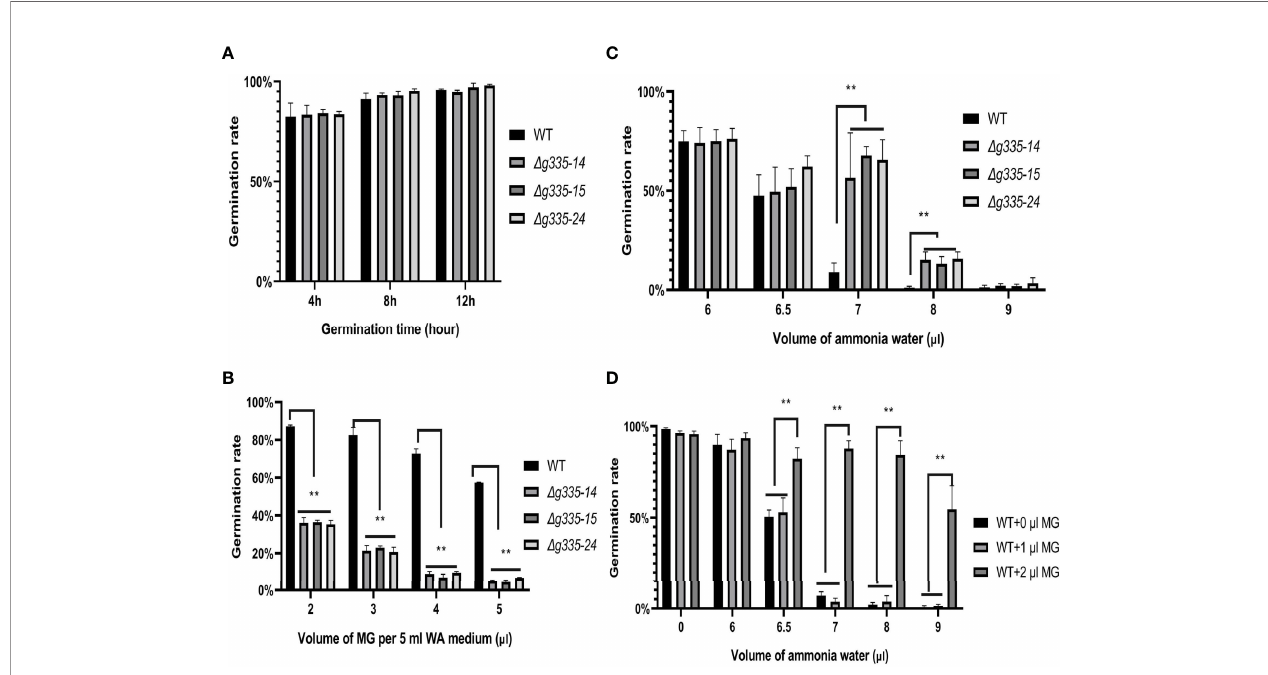
FIGURE 3 | Measurement of ammonia resistance of mutant strains on WA medium. (A) Determination of conidial germination rates of mutant and wild-type strains at 4, 8, and 12 hours. (B) Determination of conidial germination rates (24 h) of mutant and wild-type strains on WA medium containing different volume of MG. (C) Determination of the fungistatic effect of ammonia on the conidial germination rates (24h) of mutant and wild-type strain. (D) Exogenous MG relieved the fungistatic inhibition of ammonia on the conidial germination of wild-type strain. WT, wild-type strain. D g335-14 , D g335-15 , and D g335-24 : AOL_s00004g335 knock-out mutants. **P <